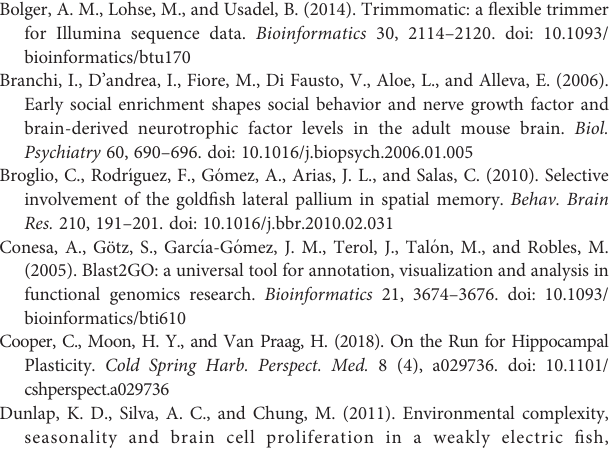
Figshare link (Trinity Assembly) with 64 annotation genes differentially expressed: https:// fi gshare.com/articles/64_DE_ genes_EE_IE_Trinity_Assembly_Pereira_et-al_2020- fi nal- anotation_fasta/12345791. Public link of FASTQ fi les submitted to NCBI SRA: